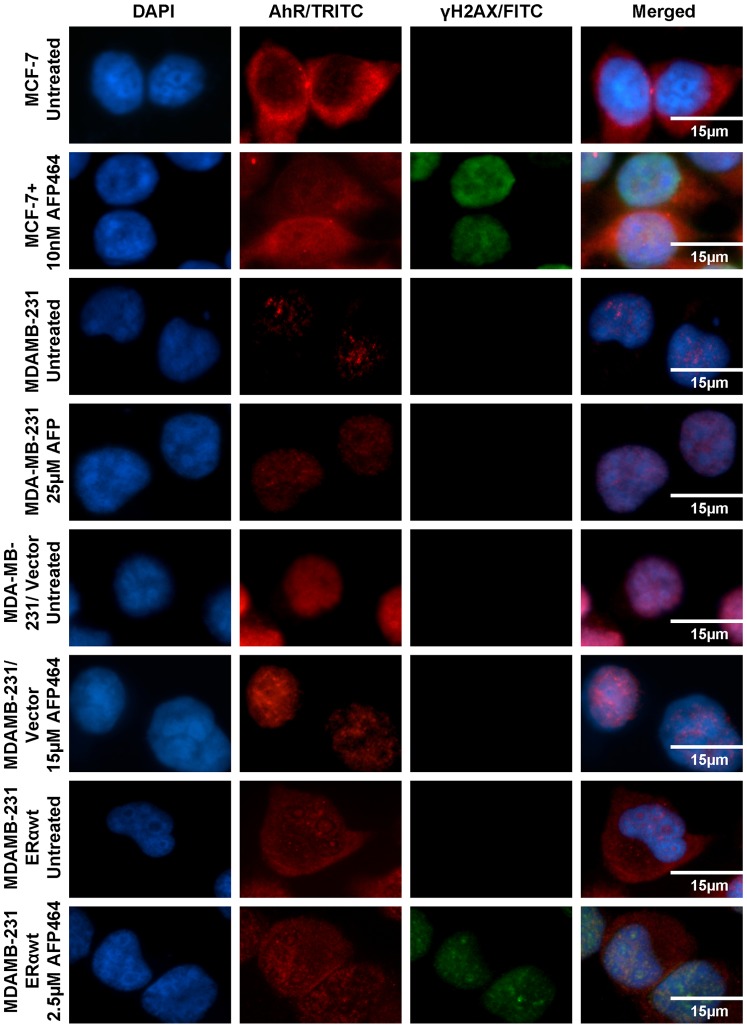
Immunofluorescence staining of AhR and γ-H2AX (a biomarker for DNA double-strand breaks) showed that stable transfection of ERα to MDA-MB-231 cells resulted in translocalization of the AhR from the nucleus to the cytoplasm and rendered cells sensitive to AFP464.The AF-sensitive, ERα-positive MCF-7 cell line was used as a positive control. The AhR was localized predominantly in the cytoplasm in MCF-7 and MDA-MB-231/wtERα cells, but was localized in the nucleus in the parental or empty vector-transfected MDA-MB-231 cells. Nuclear γ-H2AX foci formed in MDA-MB-231/wtERα cells but not in the parental or empty vector-transfected cells when the cell lines were treated with AFP464 at their respective IC50 values for 24 h. The blue DAPI, red TRITC, and green FITC staining indicates positive staining for the nucleus, AhR, and γ-H2AX foci, respectively.